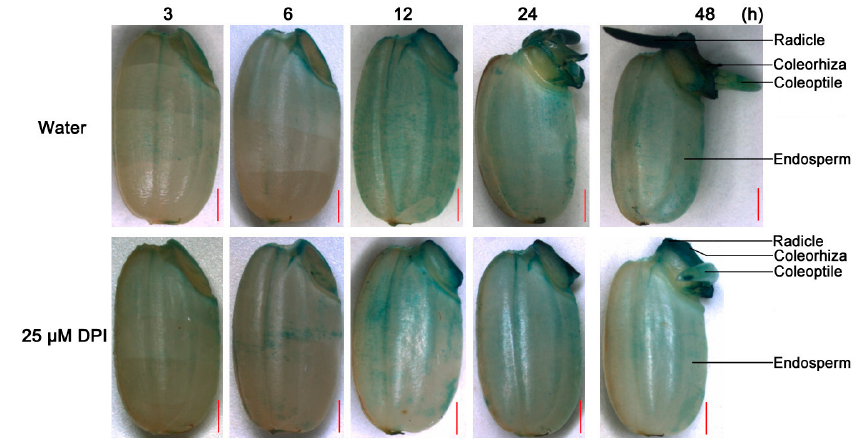
Figure 5. Histochemical detection of peroxidase activity in rice seeds incubated in water or with DPI. Histochemical staining by TMB for the localization of peroxidase activity detected in whole seeds incubated in water or with 25 μ M DPI for 3, 6, 12, 24 and 48 h. Scale bar, 1000 μ m.